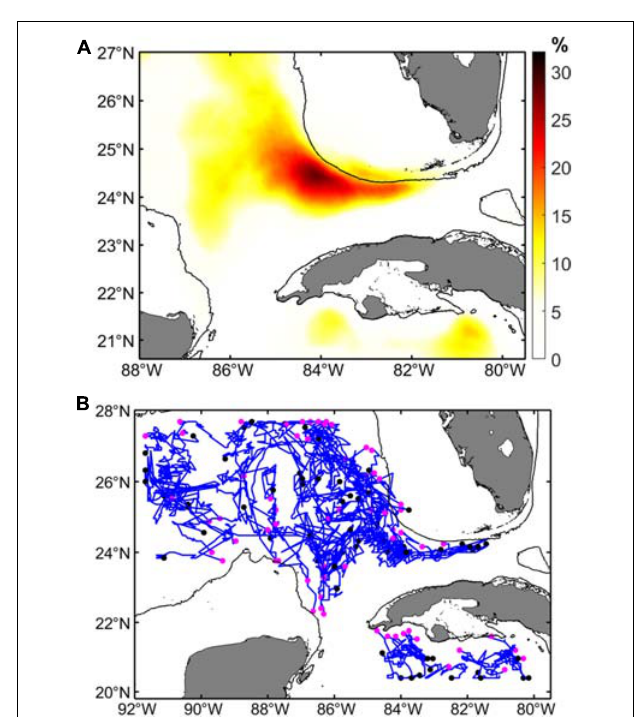
FIGURE 14 | (A) Long-term mean occurrence frequency of the CEs with a lifespan more than 5 days in the southeastern GoM, SoF, and northeastern Caribbean Sea during 2010–2015, derived from global HYCOM simulations. Color shadings represent the percentage of pixels where a location is inside an eddy. (B) Trajectories of CEs with a lifespan longer than 30 days, determined from daily global HYCOM surface current velocity data from 2010 to 2015, based on the AMEDA algorithm. The magenta and black dots in (B), respectively, denote the start and end locations of each eddy track. The 200 m isobath is annotated with black lines in each